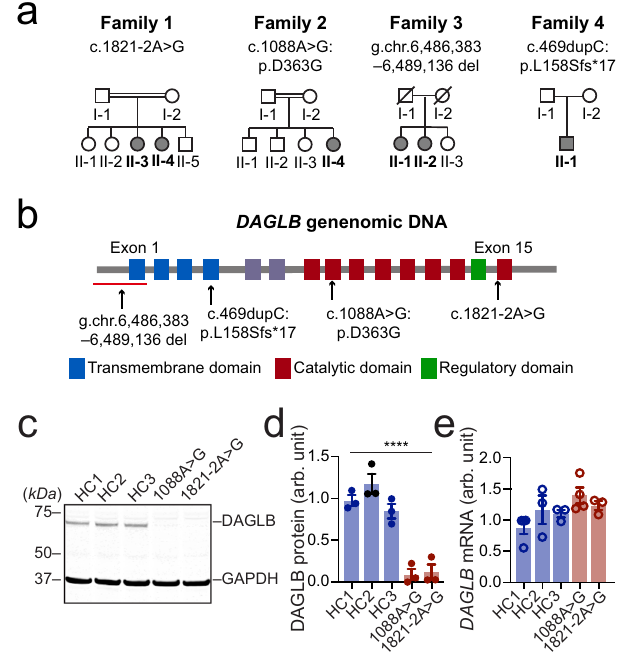
Fig. 1 Identi fi cation of homozygous DAGLB mutations in affected families. a Pedigrees are shown for the four affected families. A double bar represents parental consanguinity. Slash indicates deceased individuals. Males are represented by squares, females by circles, and affected individuals by shading. b Schematic view of DAGLB gene structure and encoded protein domains. The four transmembrane segments are shown in blue, and the catalytic domain in maroon. Within the catalytic domain, a regulatory loop is colored in green. Variant sites are indicated by arrows. c – e Representative western blot ( c ) and quanti fi cation of DAGLB protein ( d ) and mRNA ( e ) levels in fi broblasts derived from Family 1 II-3, Family 2 II-4 and three age-matched HCs. N = 3-4 independent fi broblast cultures. Data were normalized to glyceraldehyde 3-phosphate dehydrogenase (GAPDH) protein or mRNA levels as appropriate and represent mean ± SEM. One- way ANOVA, F = 33.09, **** p <